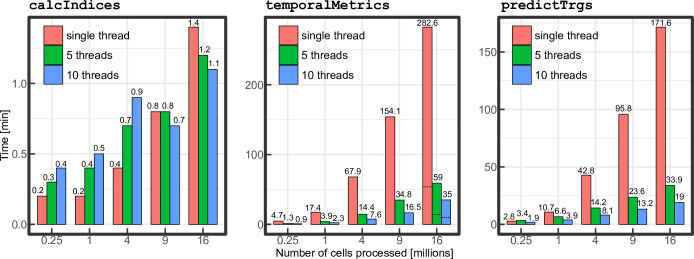
Computing times, in minutes, required to process calcIndices, temporalMetrics and predictTrgs with 5 datasets of different sizes on single and multiples threads.Dashed lines for the 4000 x 4000 pixels in temporalMetrics represent computing times without calculating the Theil–Sen slope.